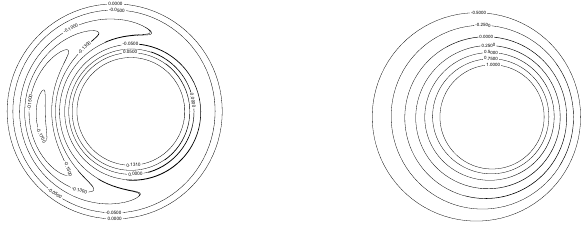
Figure 8. Stream function (left) and vorticity (right) results for Re =100 and ε = 0 . 3 . Outer wall rotates with u θ